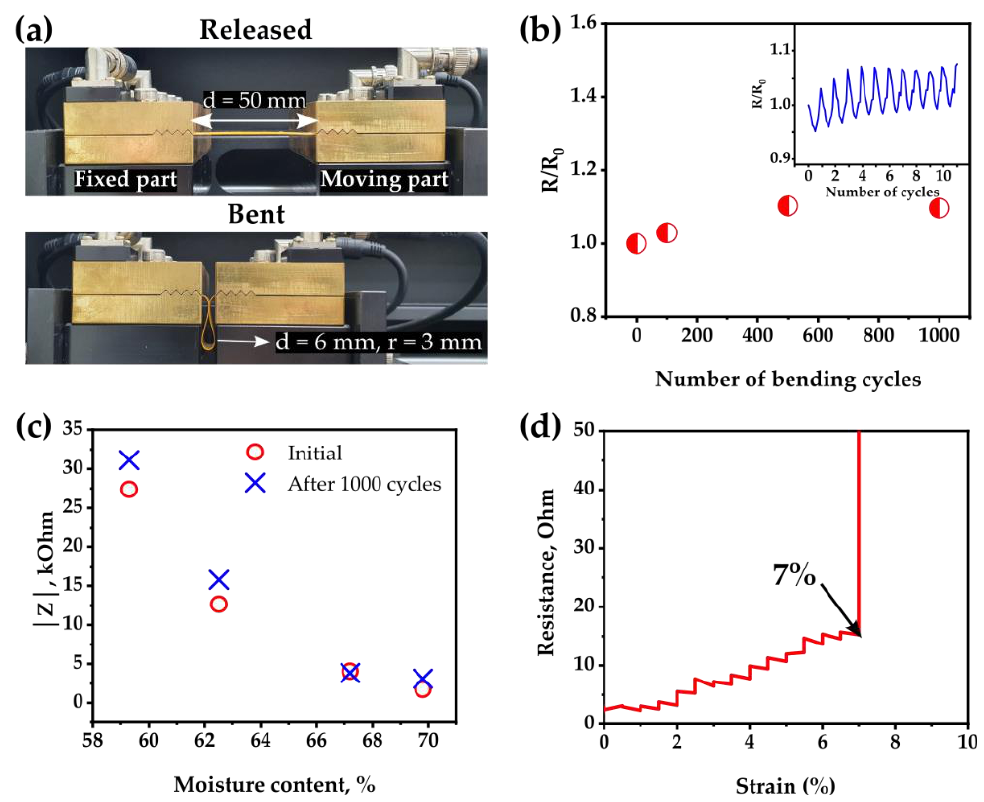
Figure 5. ( a ) Experimental setup of cyclic bending test for the verification of durability of the sensor. ( b ) Change in the resistance of the electrode after repetitive bending of the sensor. ( c ) Comparison of the impedance values of porcine skin with different hydration levels at 100 kHz before and after 1000 times of bending. ( d ) Change in the resistance of the electrode while applying tensile strain.